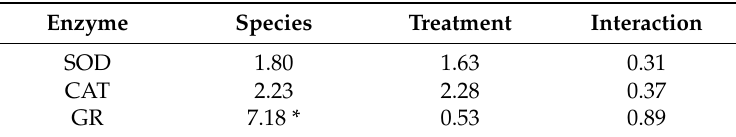
Table 8. Two-way analysis of variance (ANOVA) of the species, treatment and their interactions for the activity of the antioxidant enzymes: superoxide dismutase (SOD), catalase (CAT), and glutathione reductase (GR) in foliar tissue. Numbers represent F values. Statistically significant di ff erences at p -value = 0.05 (*). Enzyme